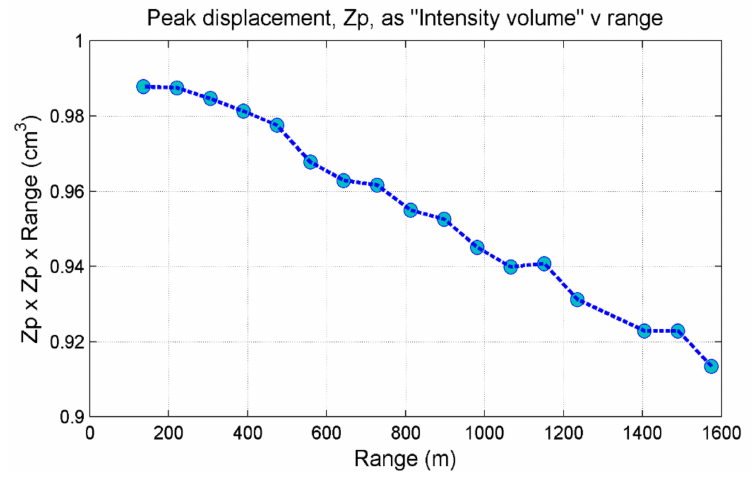
Figure 11. The reduction in peak vertical displacement analysed as a displaced